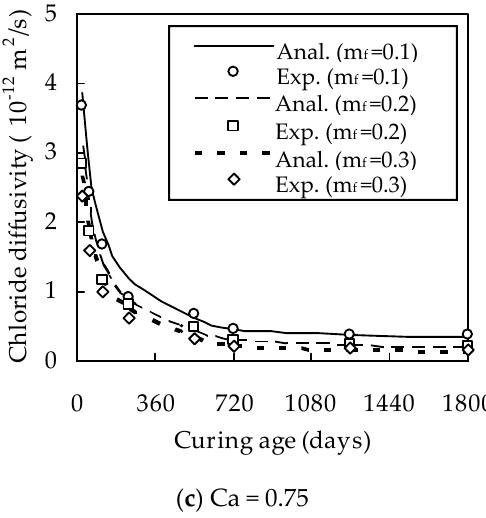
Figure 3. Variation of D cf with t for w/b = 0.5.